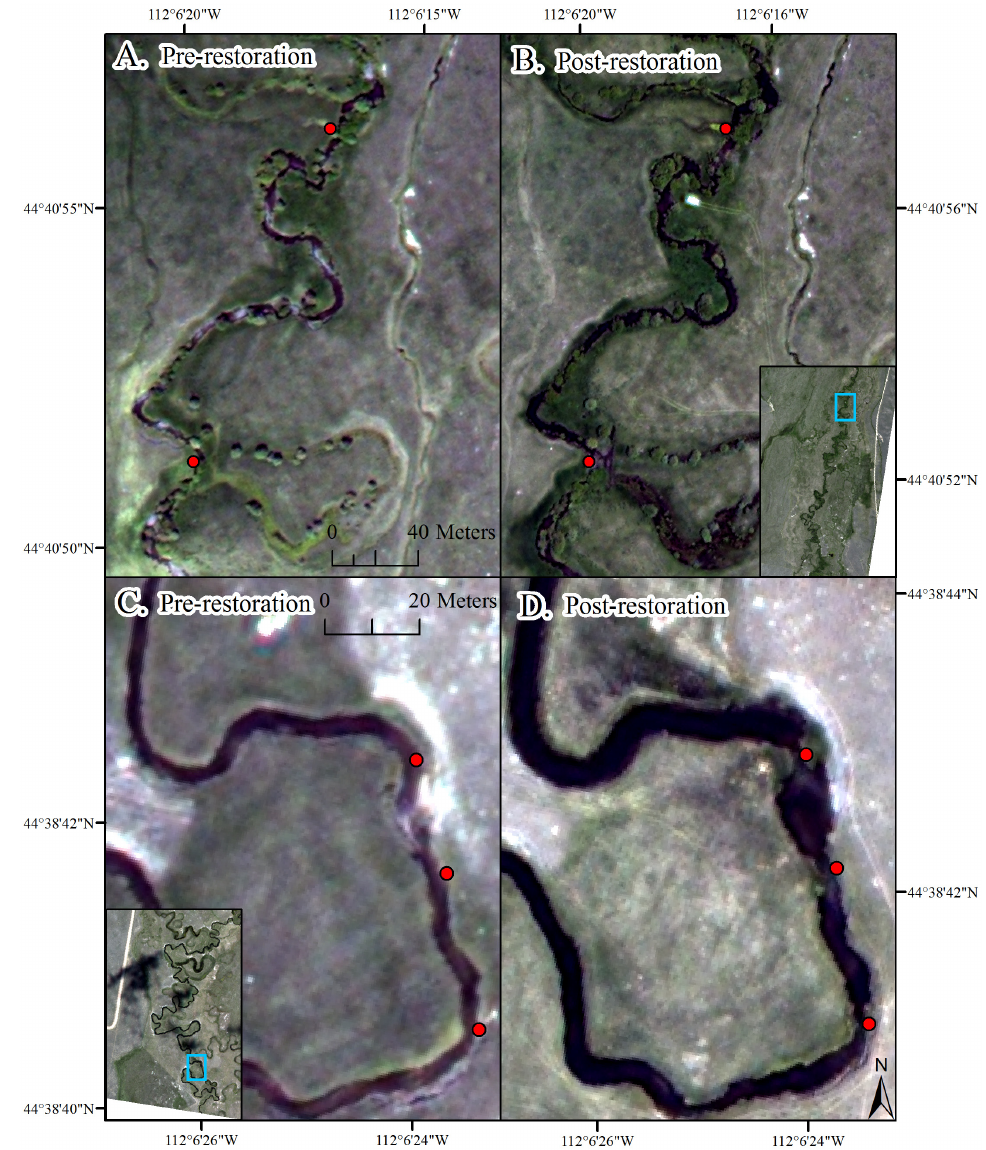
Figure 9. Visually apparent changes with the installation of the beaver dam analogues varied along Long Creek. Within Long Creek (North) changes from pre ‐ to post ‐ restoration included retention of water upstream from structures as well as the reactivation of abandoned side channels ( A , B ); Along Long Creek (South) changes included widening of the stream as well as retention of water upstream from structures ( C , D ). Copyright DigitalGlobe 2014, 2017.